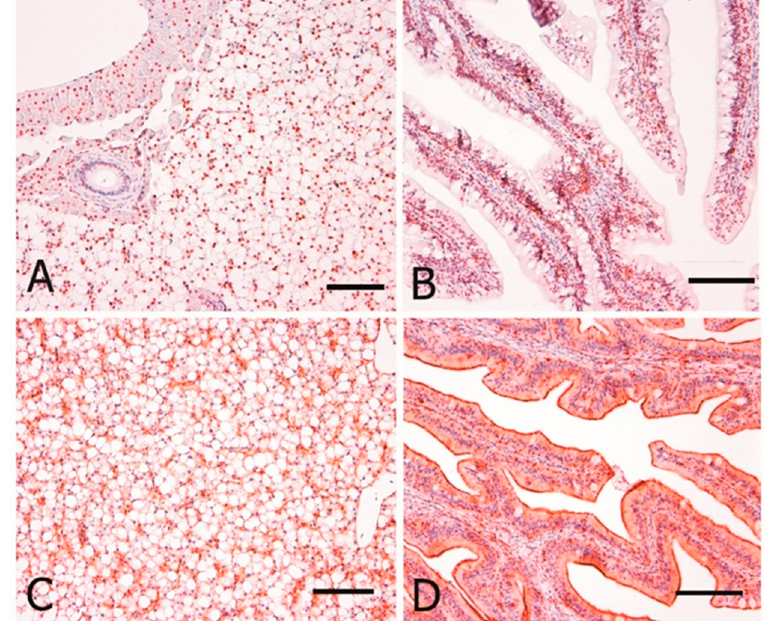
Figure 4. Immunohistochemical localization of CYP1A and 8-OHdG in sea bass. All panels are counterstained with Harryr’s hematoxylin. Scale bar: 50 μ m. ( A ) Liver, strong and diffuse nuclear immunoreactivity of hepatocytes to anti-8-OHDG antibody; ( B ) Gut, nuclear immunoreactivity of most enterocytes to anti-8-OHDG antibody; ( C ) Liver, endothelial, and sinusoidal immunoreactivity of hepatocytes to anti-CYP-1A; ( D ) Gut, diffuse strong immunoreactivity of the intestinal mucosa to anti-CYP-1A.